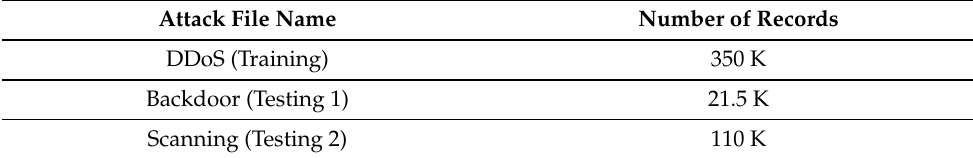
Table 5. The final count of records in all files.